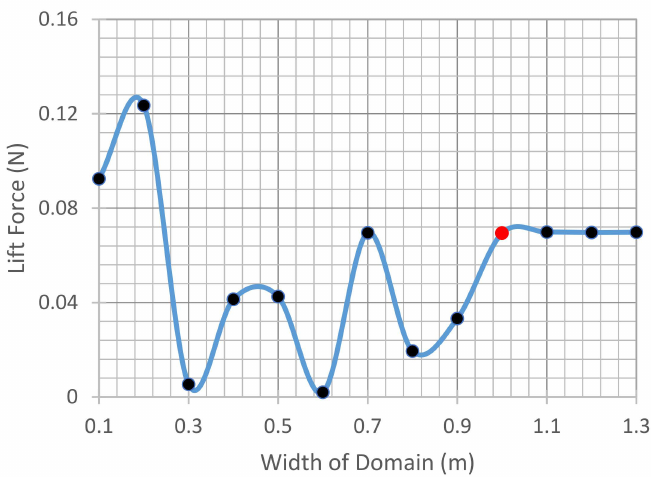
Figure 17. Domain Width Convergence Plot.